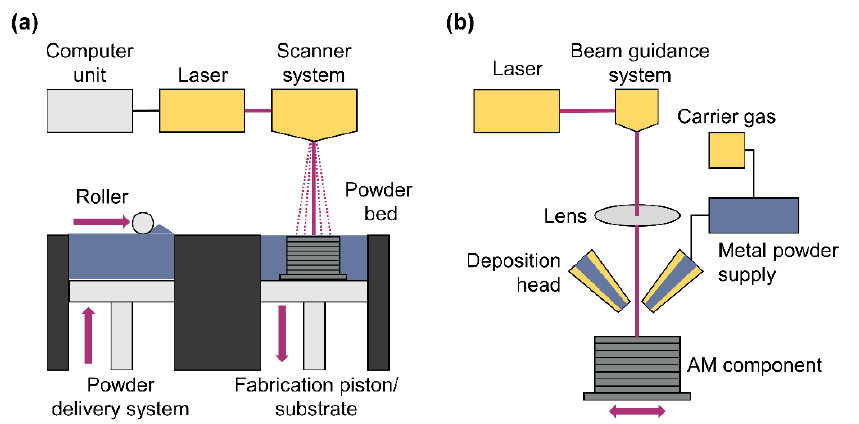
Figure 1. Schematic diagram ( a ) direct metal laser sintering (DMLS) or selective laser melting (SLM) and ( b ) direct energy deposition (DED) processes. Redrawn from [18,45] with permission by CC